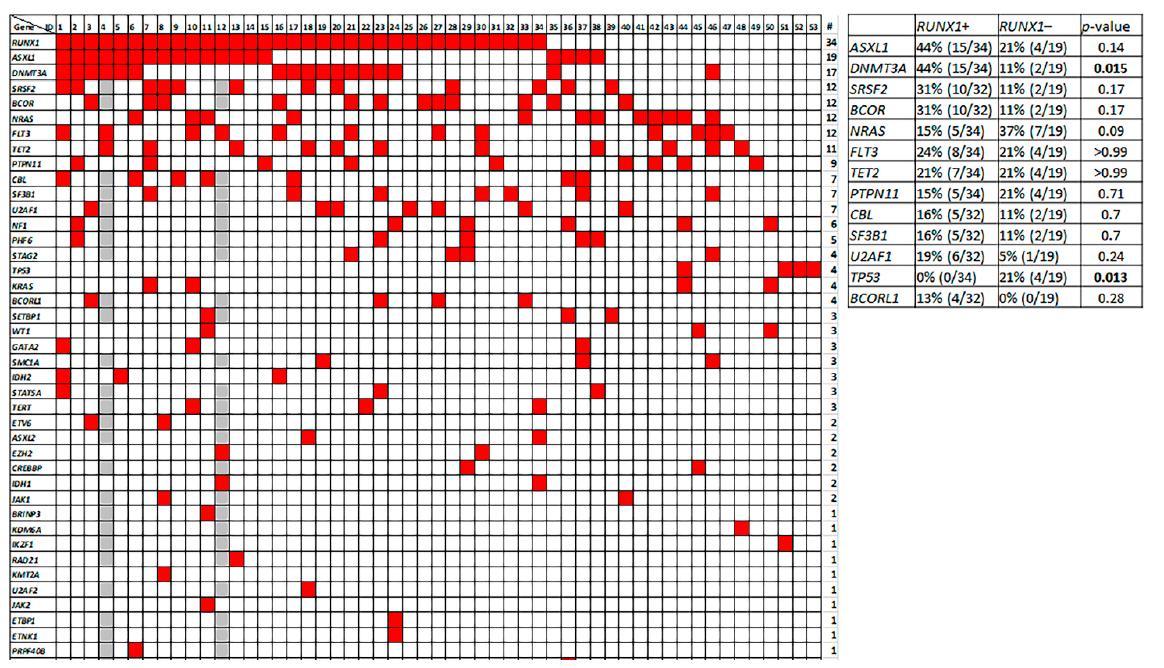
Figure 5. The mutational profile of pDC-AML. Cases # 1–34 with RUNX1 mutation, and cases # 35–53 with wild type RUNX1 . The case number in this figure correlates with the case number assigned in Figure 1.